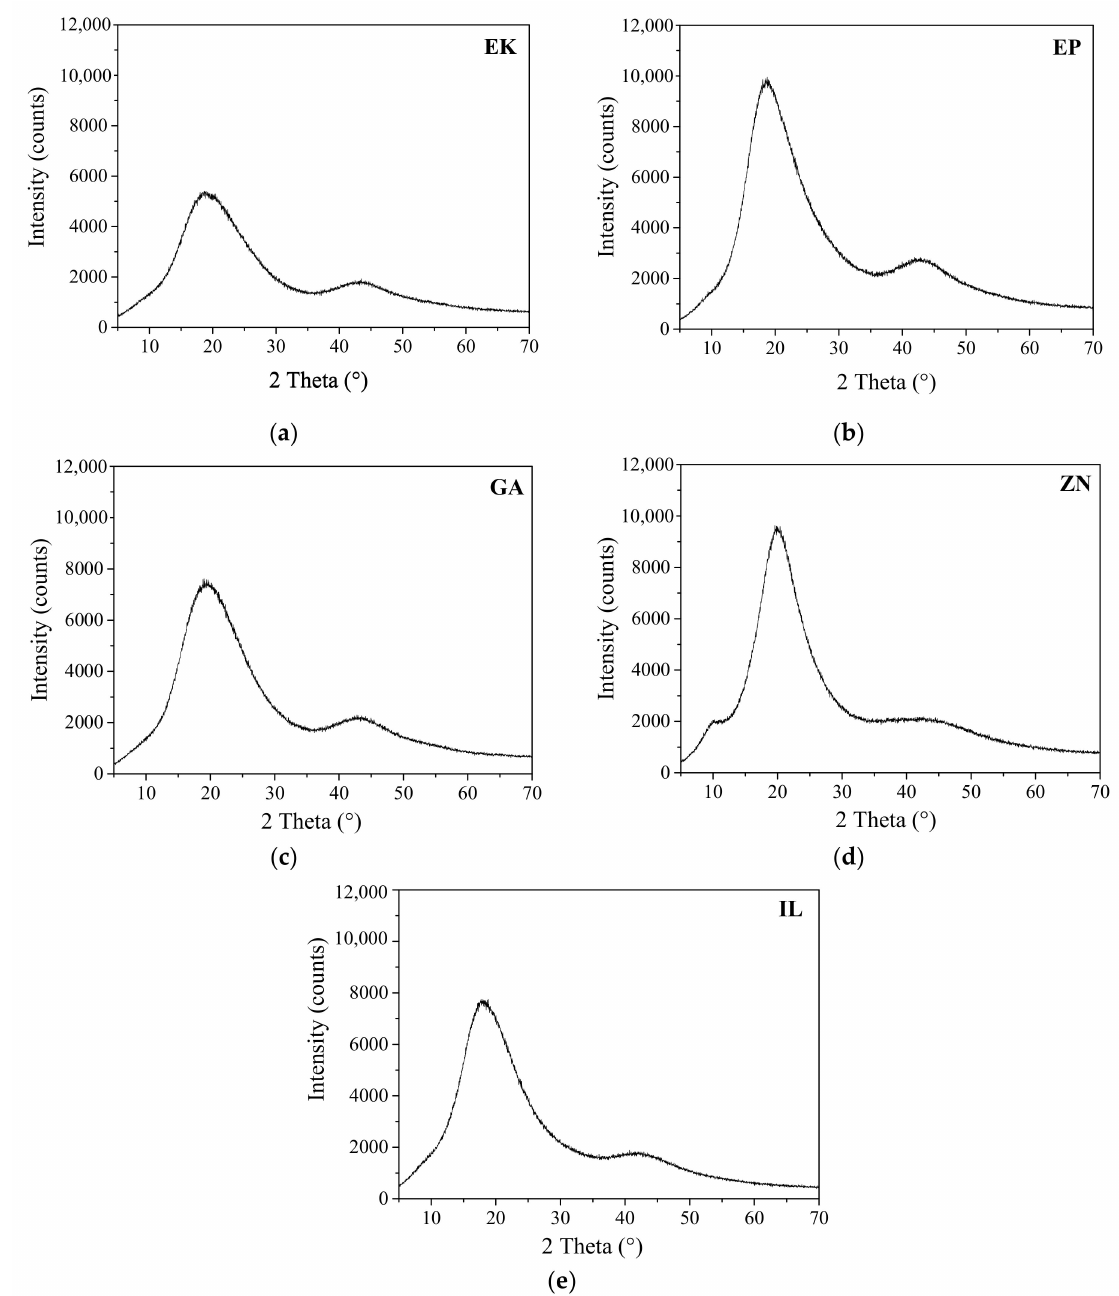
Figure 1. XRD patterns of the considered aligners: ( a ) Erkodur (EK); ( b ) Essix Plastic (EP); ( c ) Ghost Aligner (GA); ( d ) Zendura (ZN); ( e ) Invisalign